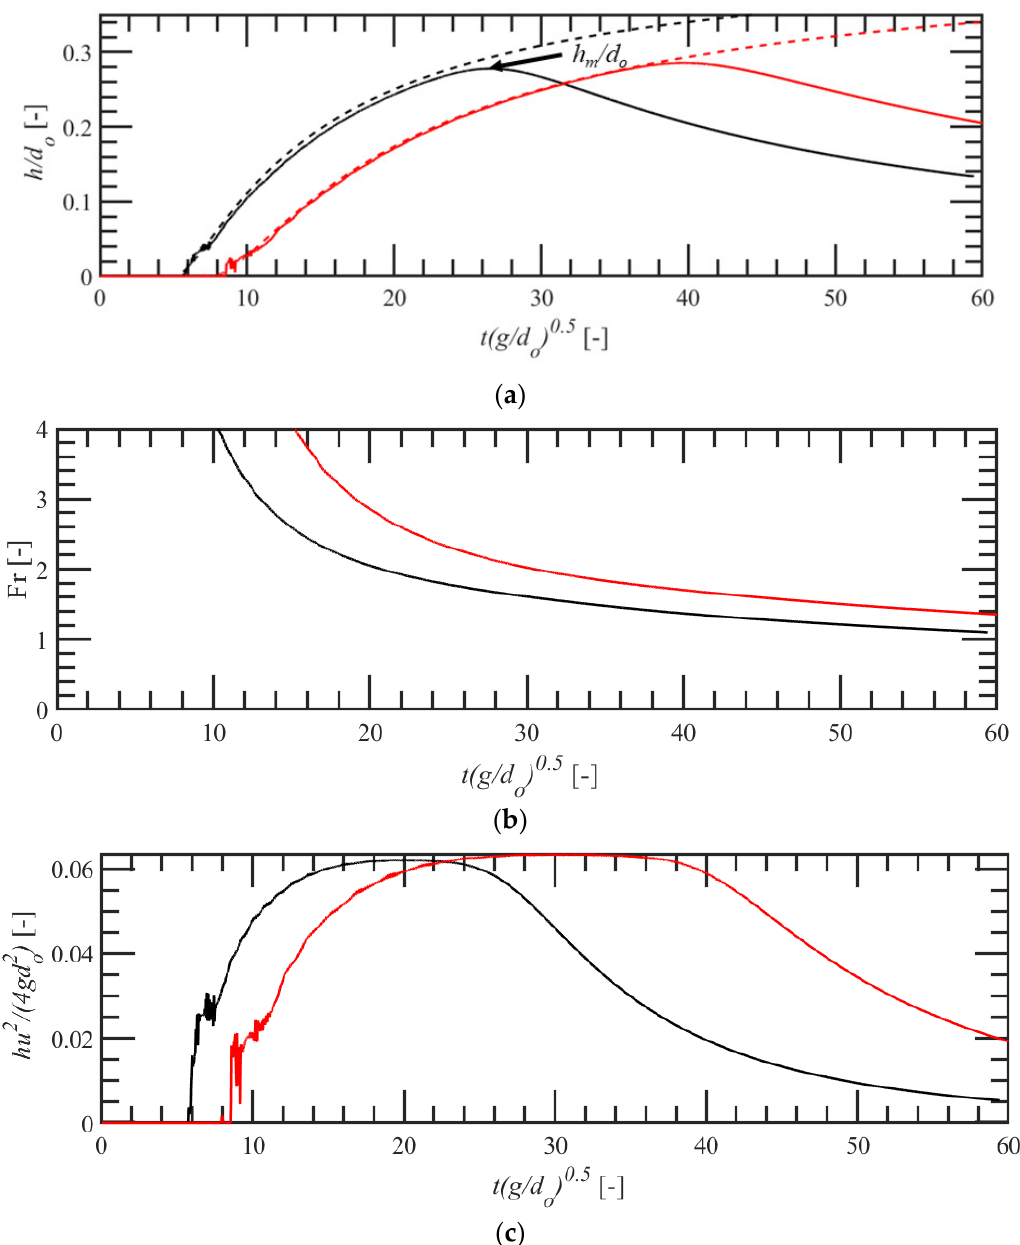
Figure 5. ( a ) Comparison of simulated non-dimensional surge front profile with the theoretical solution of Ritter (1892) at the location of mitigation wall ( X = 9 m) in its absence; ( b ) Froude number of the simulated surge at X = 9 m; ( c ) Non-dimensionalized momentum flux of the simulated surge at X = 9 m. Red indicates d o = 0.6 m and black indicates d o = 0.9 m. Solid lines indicate simulation results, and the dashed line indicates Ritter’s [62] solution.